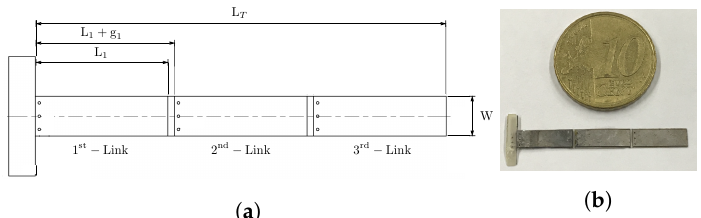
Figure 3. The three-link IPMC-based AEF swimming robot: ( a ) mechanical design, ( b ) image of the real prototype. Table 1. Geometrical parameters of the IPMC-based AEF swimming